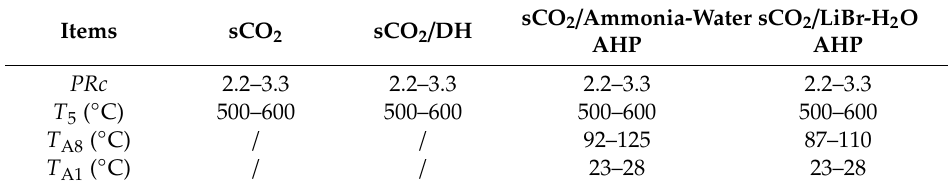
Table 13. Boundary conditions of decision variables for the PSO